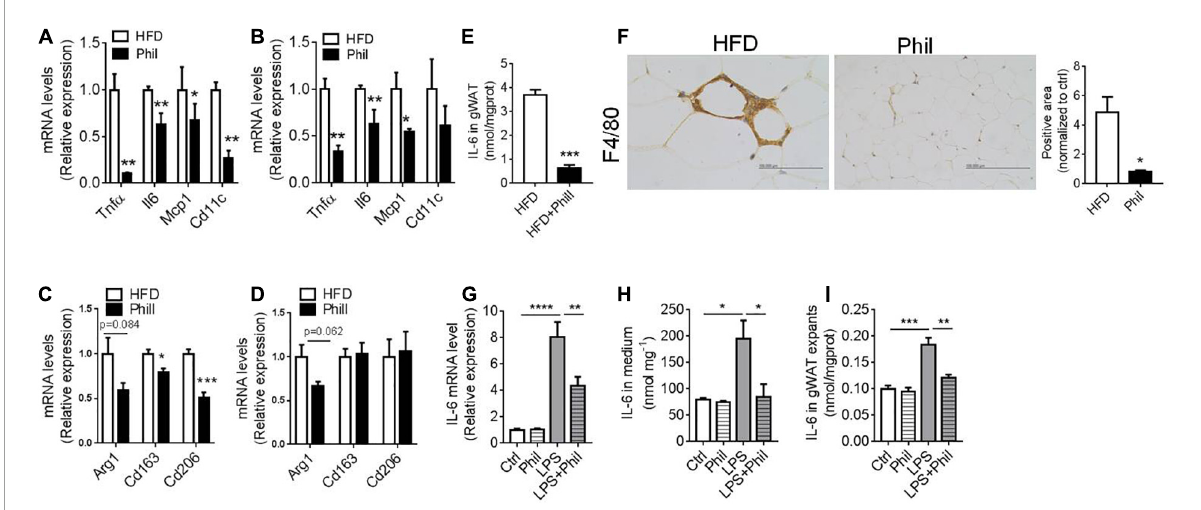
FIGURE1 Phillyrin inhibits adipose tissue inflammation and IL-6 production. (A–F) HFD-fed mice treated with or without 25 mg per kg body weight Phillyrin. mRNA levels of M1 ATM in gWAT (A) and sWAT (B) in mice. N = 4 per group. mRNA levels of M2 ATM in gWAT (C) and sWAT (D) in mice. N = 4 per group. (E) IL-6 contents in gWAT in mice. N = 3 per group. (F) Representative images of IHC and quantification of F4/80 in gWAT in the groups indicated. Magnification × 400. Scale bars, 100 µ m. N = 3 per group. (G–I) The gWAT pieces of WT mice were cultured for 24 h in DMEM containing 2% FFA-free BSA with 500 ng/ml LPS or 200 µ M Phillyrin for 24 h. N = 3 per group. (G) mRNA levels of IL-6 in the gWAT explants. (H) IL-6 level in medium. N = 3 per group. (I) IL-6 content in the gWAT explants. All data in the figure were presented as mean ± SEM. * P < 0.05, ** P < 0.01, *** P < 0.005, and **** P <